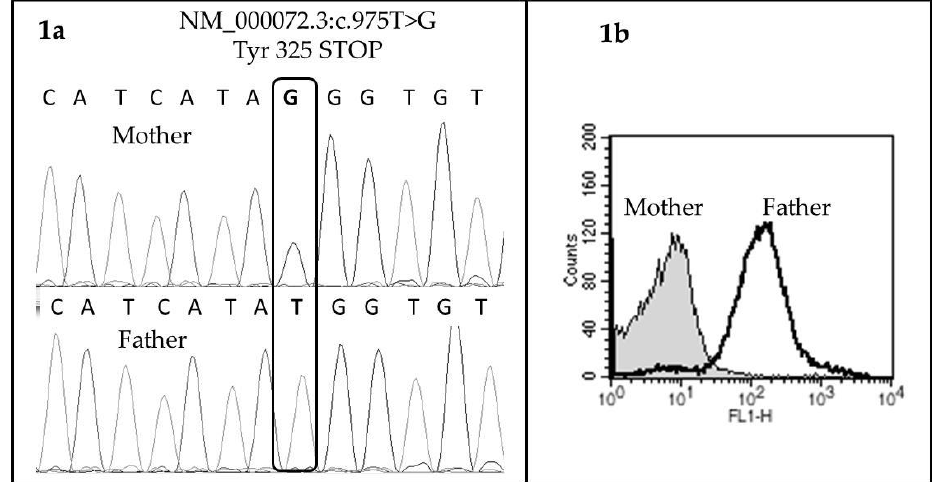
Figure 1. Platelet CD36 deficiency in a context of maternal iso-immunization. Molecular basis of the mutation by Sanger sequencing of Exon 10 CD36 gene ( a ), and flow cytometry of platelets from the mother and the father using FITC-labeled anti CD36 mouse monoclonal antibody clone 10.5 ( b ).